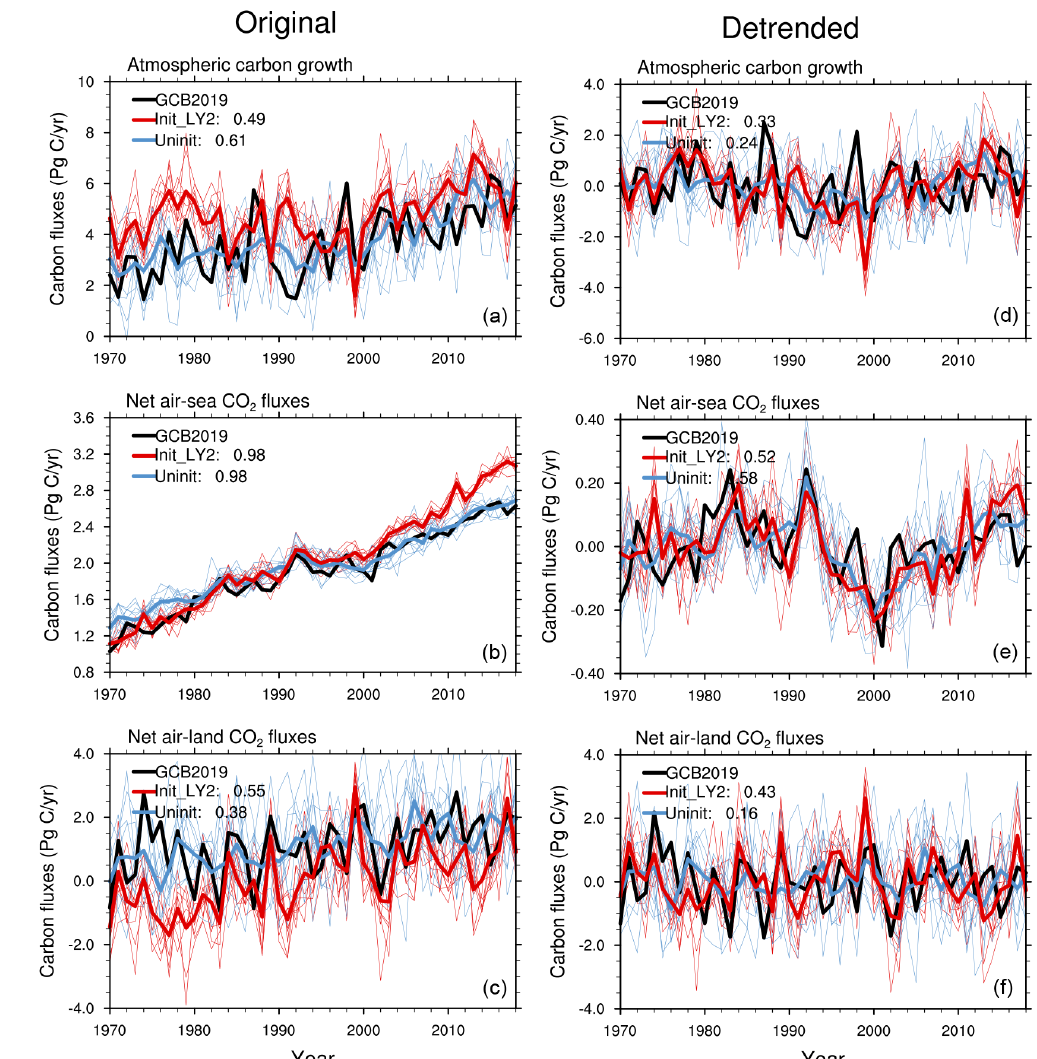
Figure 6. Time series at a lead time of 2 years for atmospheric carbon growth rate, i.e., G ATM (a) , net air–sea CO 2 fluxes, i.e., S OCEAN (b) , and net air–land CO 2 fluxes, i.e., E LUC + S LAND (c) , from the initialized simulations together with values from the uninitialized simulations and estimates from the 2019 Global Carbon Budget (GCB 2019, Friedlingstein et al., 2019). Panels (d) , (e) , and (f) are the same as (a) , (b) , and (c) but show the linearly detrended time series. The time series shown are based on annual mean data for the time period of 1970–2018. Positive values in panels (b) , (c) , (e) , and (f) imply CO 2 fluxes into the ocean or land. The numbers in the legend show the correlation coefficients between the simulations and GCB2019, and the ensemble mean data are used for the